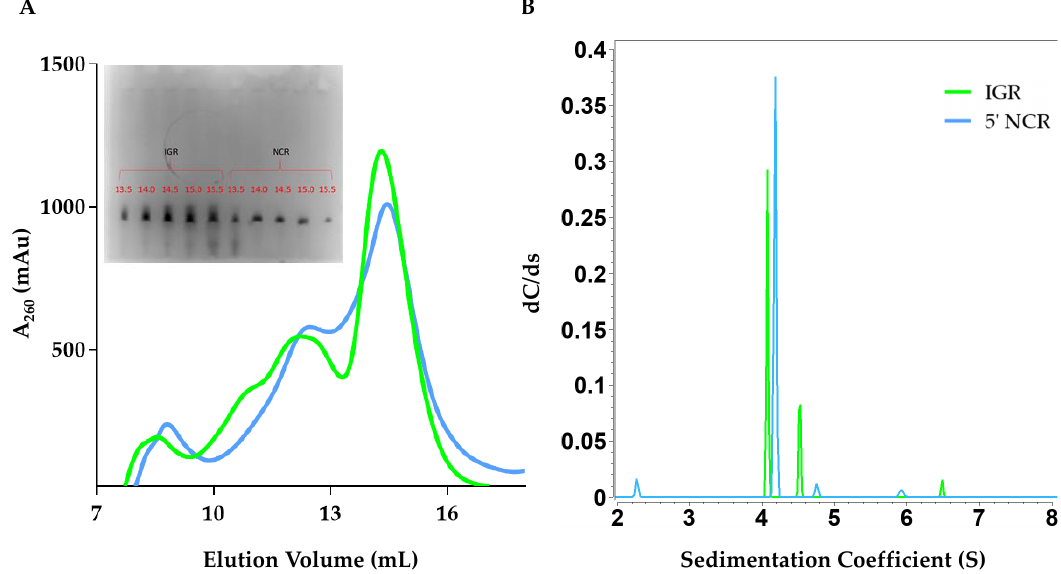
Figure 2. Purification and hydrodynamic characterization of in vitro transcribed Rift Valley fever virus RNA. ( A ) Size exclusion chromatogram of the elution profile of both Rift Valley fever virus (RVFV) 5’ intergenic region (IGR) and RVFV 5’ non-coding region (NCR). The y-axis represents absorbance at 260 nm while the x-axis represents elution volume. An inset to Figure 2A represents the urea-PAGE (7.5%) analysis of RVFV IGR and 5’ NCR after size exclusion chromatography. Each well represents 10 µ L of a 500 µ L elution fraction from size exclusion chromatography. The gel was run for 25 min, at 300 V in 0.5 × TBE (Tris-Borate-EDTA) running buffer and was visualized using Sybr Safe dye. ( B ) Sedimentation coefficient distribution profiles for RVFV 5’ IGR (green) and RVFV 5’ NCR (blue) from SV-AUC. The primary SV peaks for each RNA are 4.07 S and 4.18 S for IGR and 5’ NCR, respectively, and represent the monomeric form. Sedimentation coefficient values were corrected to standard conditions (20 ◦ C in